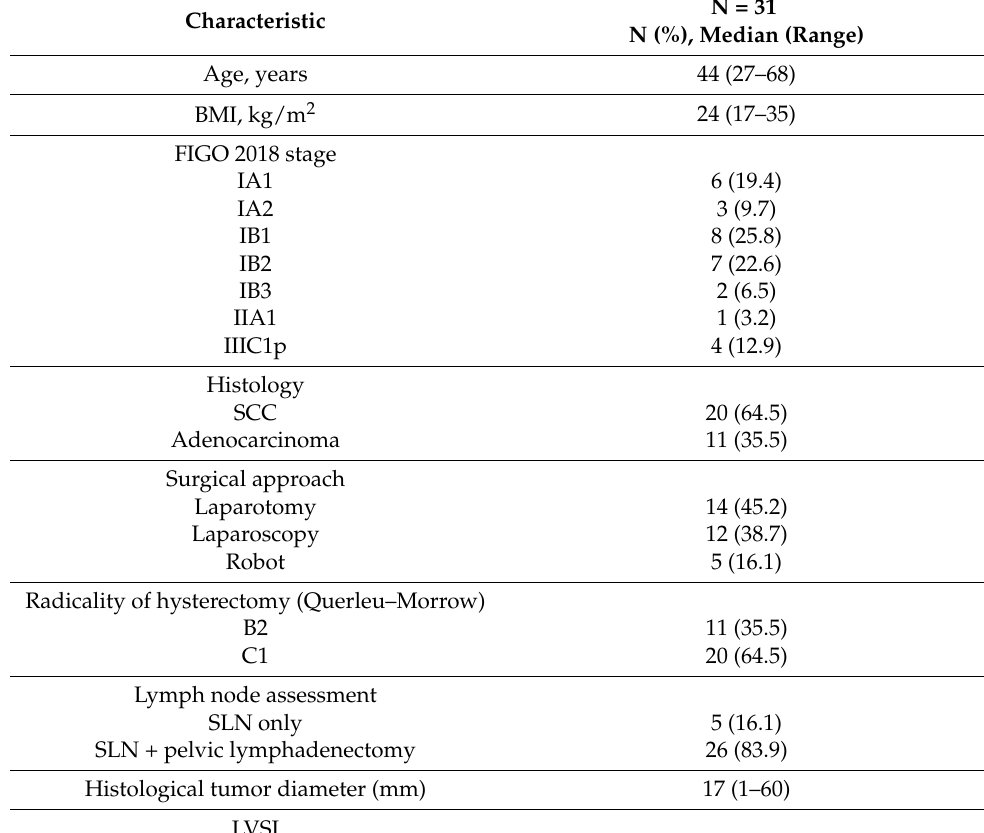
Figure 2. Flow chart showing inclusion and exclusion process. Table 1. Patient characteristics.